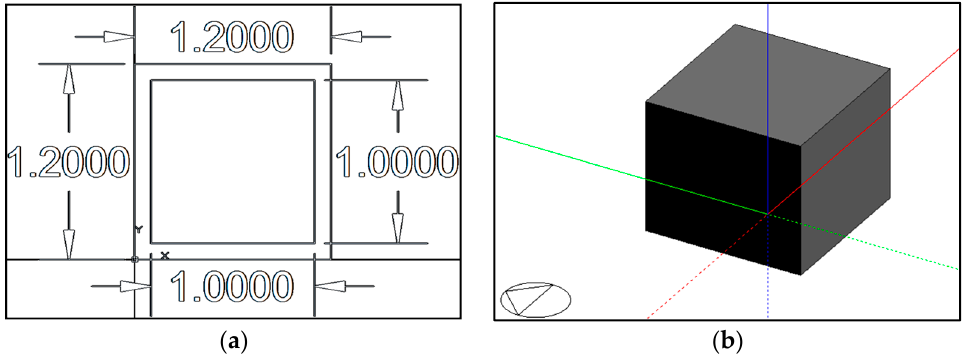
Figure 2. ( a ) A base test unit plan, and ( b ) a base test unit isometric modeled using DesignBuilder software; the triangle represents the north orientation. Table 4. Test units’ construction material’s thermophysical properties.